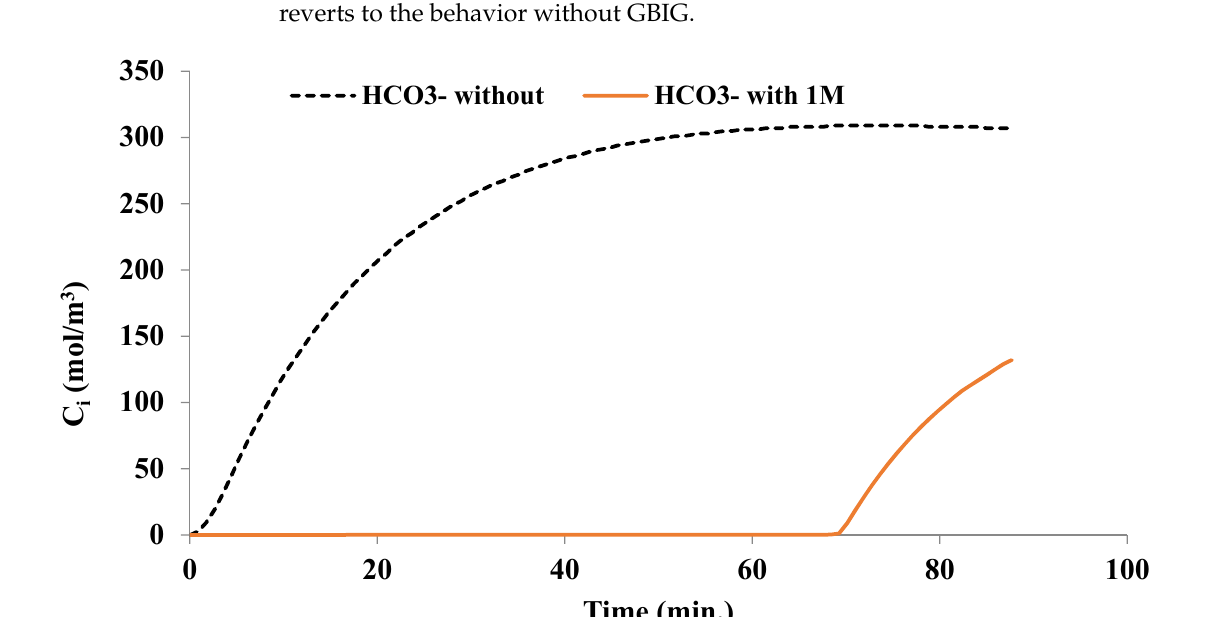
− concentration as a function of time with and without Figure 5. HCO 3- concentration as a function of time with and without GBIG. Figure 5. HCO 3